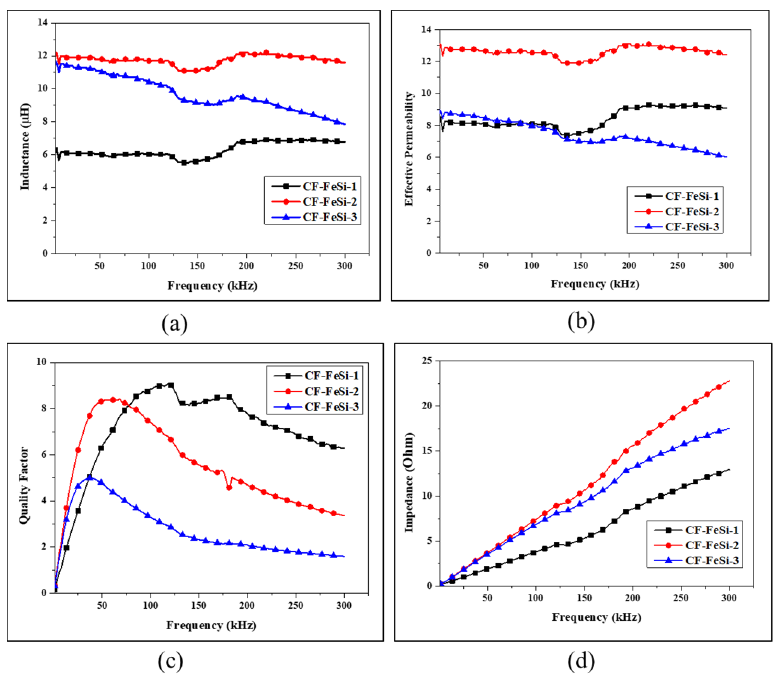
Figure 6. The characteristics of inductors with CFRP-FeSi single-sheet cores: ( a ) inductance; ( b ) effective permeability of CFRP-FeSi cores; ( c ) quality factor and ( d ) impedance.